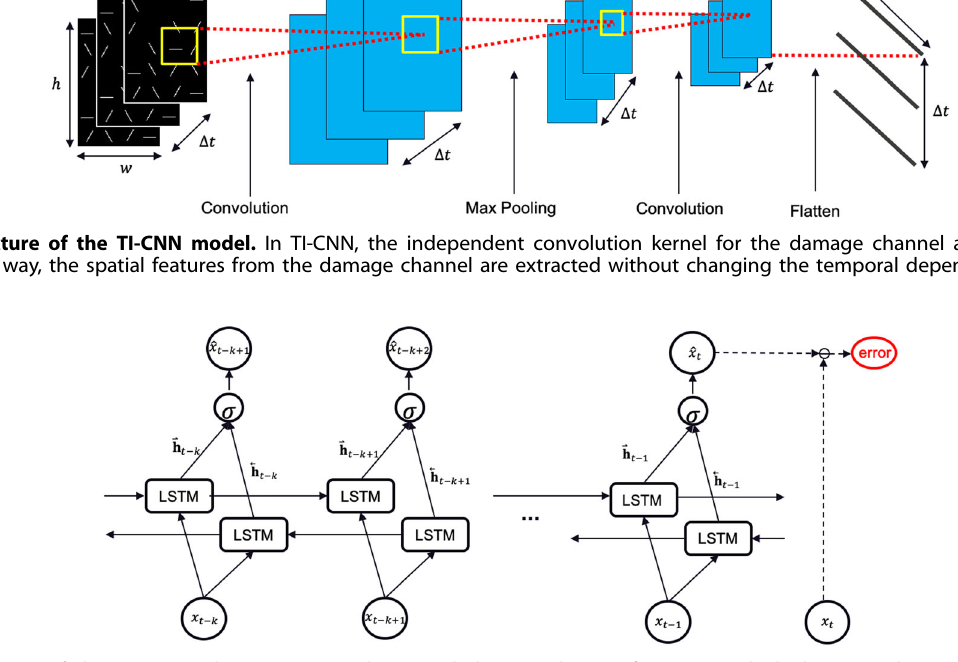
Fig. 6 Architecture of the Bi-LSTM. The Bi-LSTM can be regarded as two layers of LSTM, in which the upper layer captures the forward temporal features and the bottom layer captures the backward temporal features.